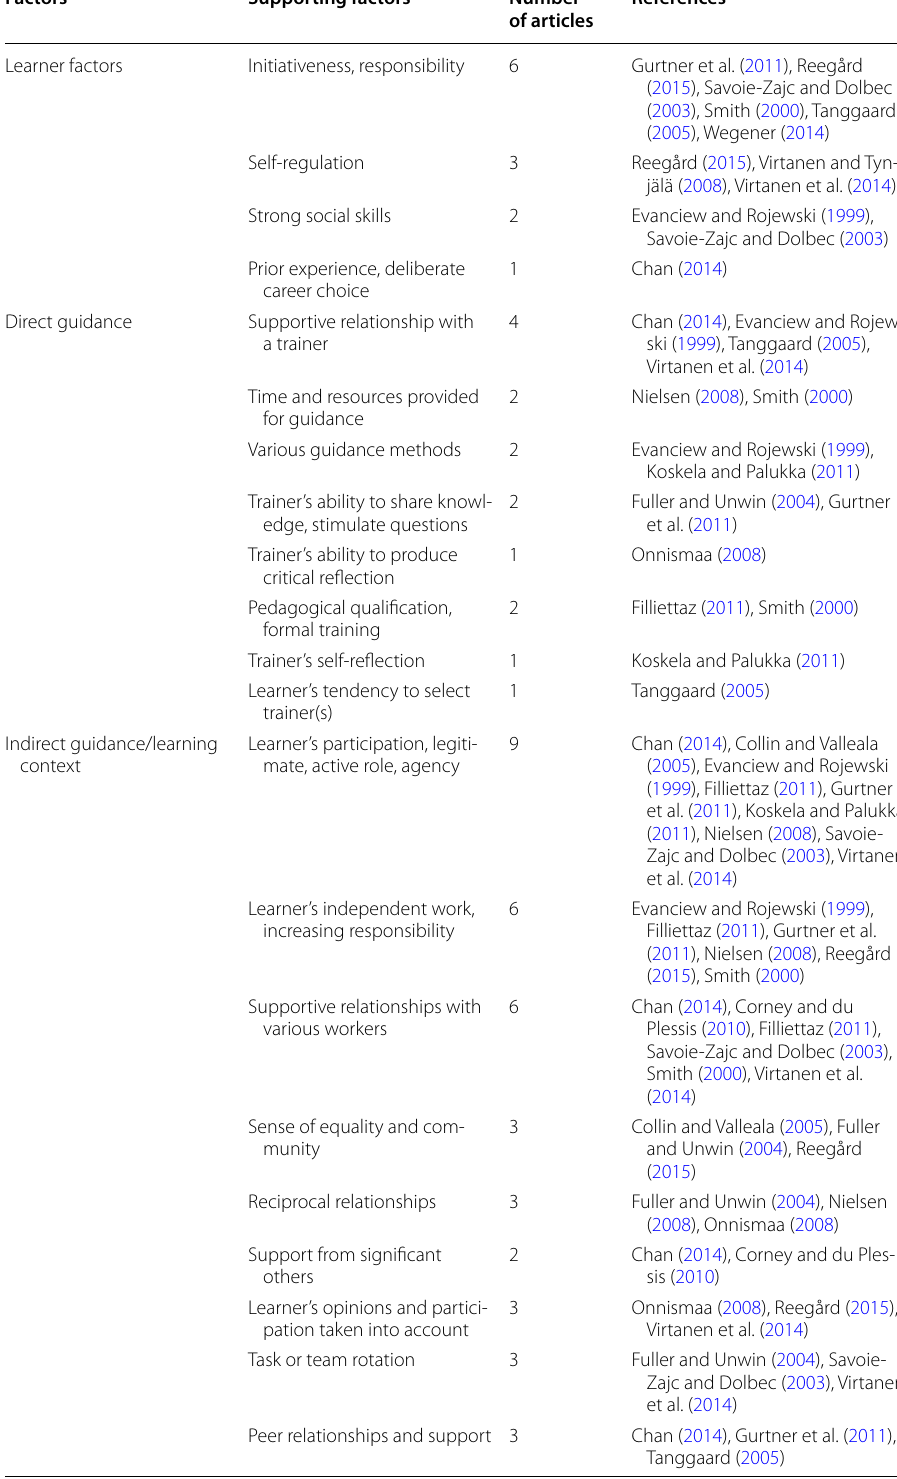
Table 4 Factors supporting